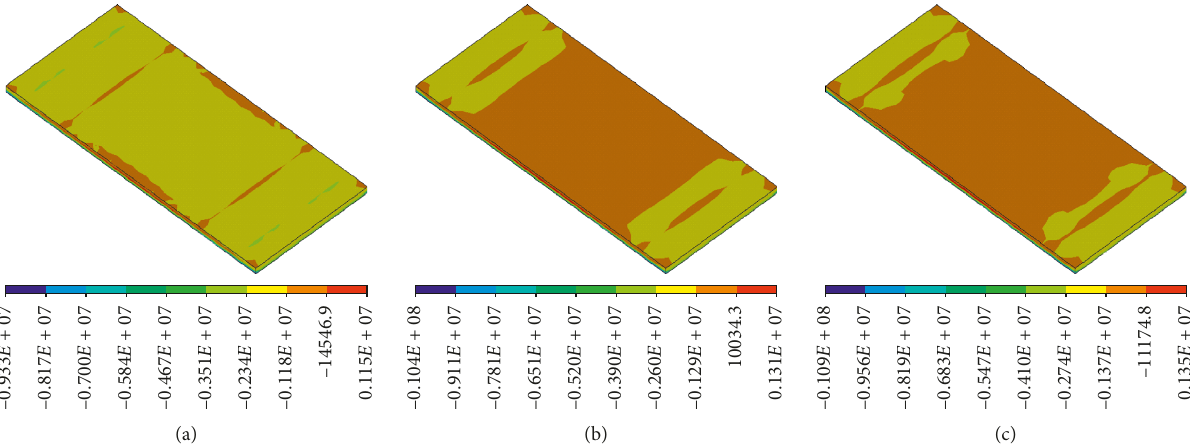
20 ° C/m temperature gradient. (a) Track slab. (b) Bed plate. −